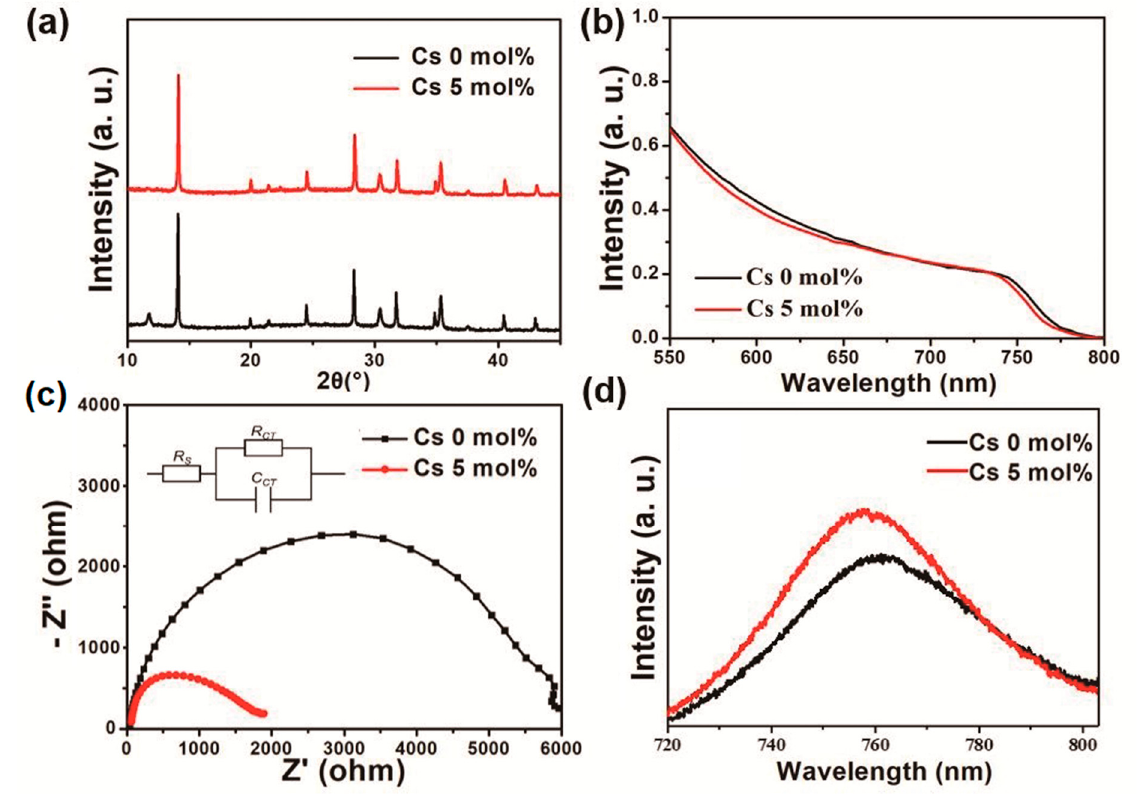
Figure 3. ( a ) XRD patterns. ( b ) Ultraviolet–visible absorption spectra of the perovskite films with different cesium doping concentrations. ( c ) Nyquist plots of the PSCs without and with 5% cesium doping with a bias of 0.8 V. ( d ) Photoluminescence (PL) spectra of the perovskite films without and with 5 mol% cesium doping.